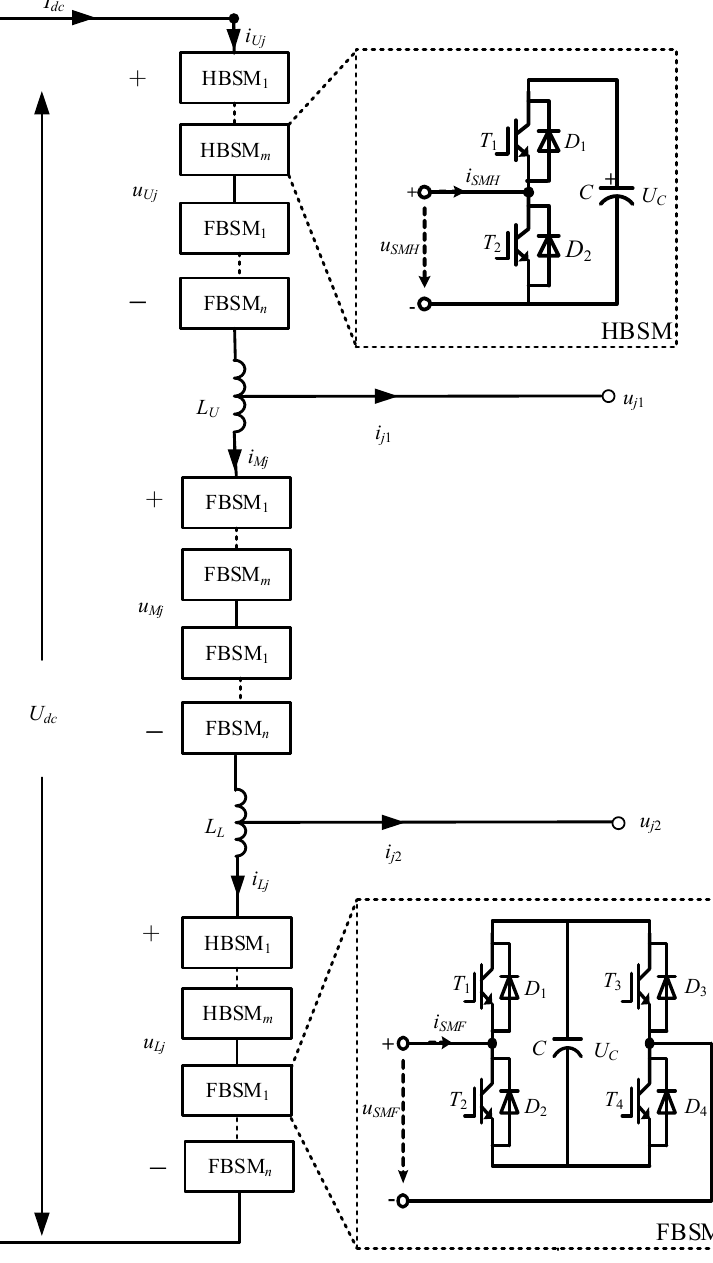
Figure 2. Single phase of the hybrid nine-arm high-voltage inverter. Inductors L U and L L are two bu ff er inductors, with L U = L L . The value U dc is the DC-link voltage and I dc is the DC-side current. The value U C is the capacitor voltage of SM and equals